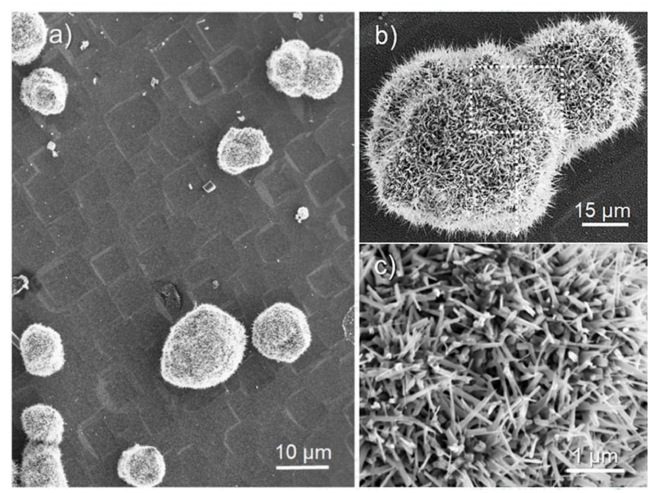
Figure 5. ( a , b ) SEM images of ZnO cages grown on Au thin film at 800 ◦ C for 3 h, ( c ) enlarged view of a selected area of ( b